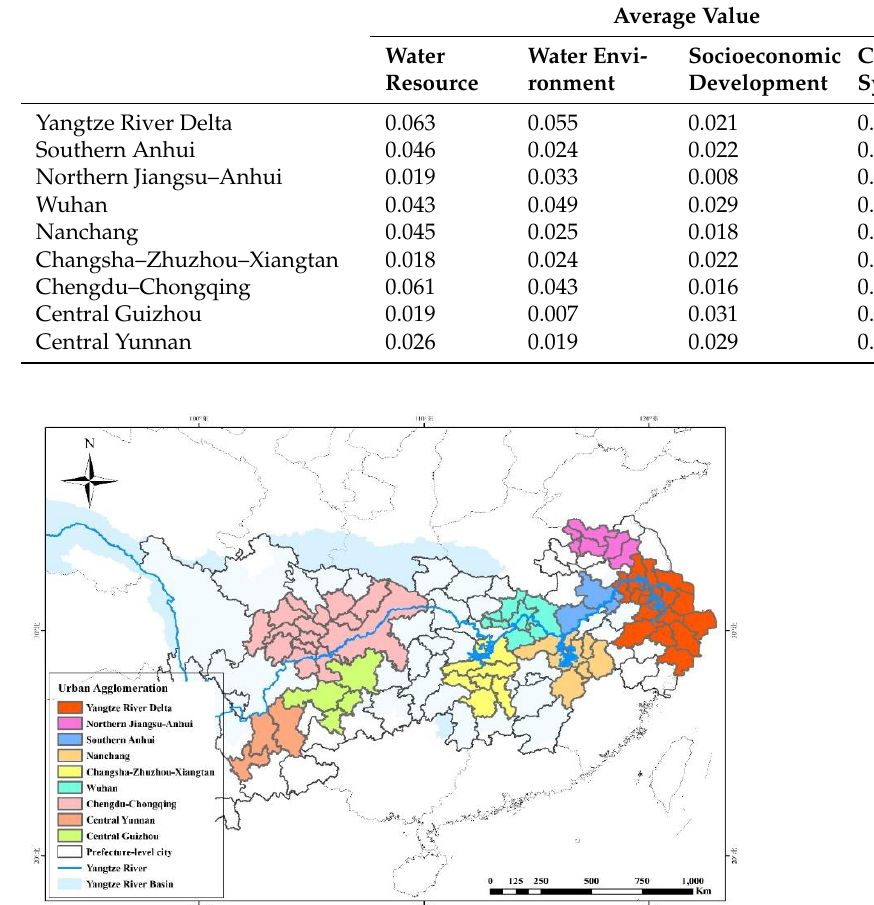
Table 11. The standard deviation of the coupling system in 110 cities.